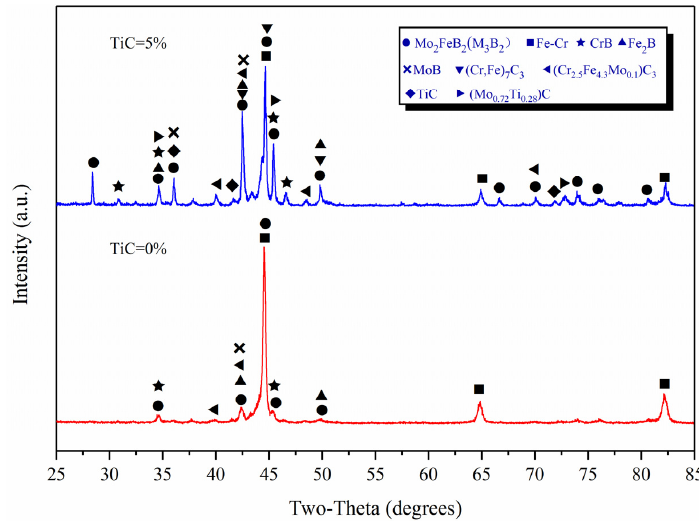
Figure 2. XRD analysis of claddings with 0% TiC and 5% TiC.